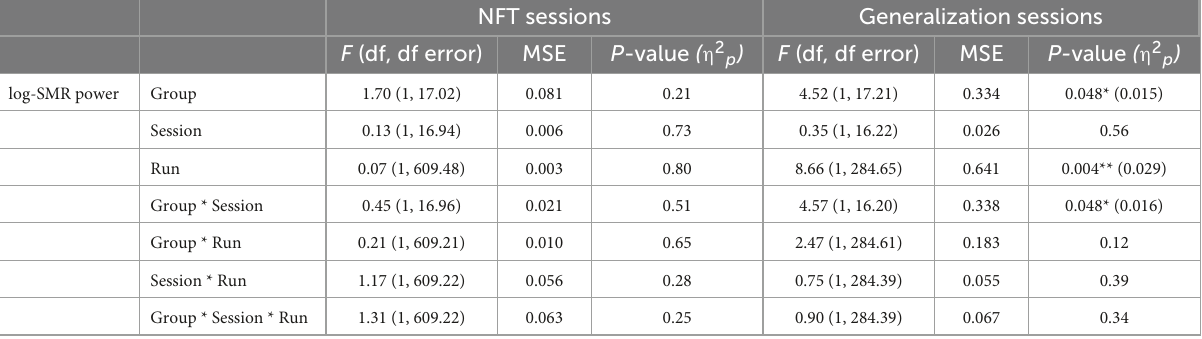
TABLE 1 Results of the mixed-effects models with the linear effects group (experimental or control group), session (early vs. late sessions), and run (early vs. late runs), and the by-subject random slope session (early vs. late sessions) for the dependent variable log-transformed sensorimotor rhythm (SMR) power, presented separately for the training and generalization sessions.